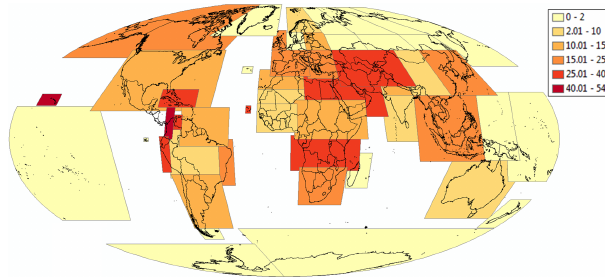
Figure 4. Percent of variance explained by cross-validated inverse distance weighting.